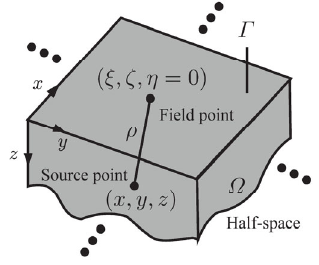
Fig. 2 Schematic representation of a